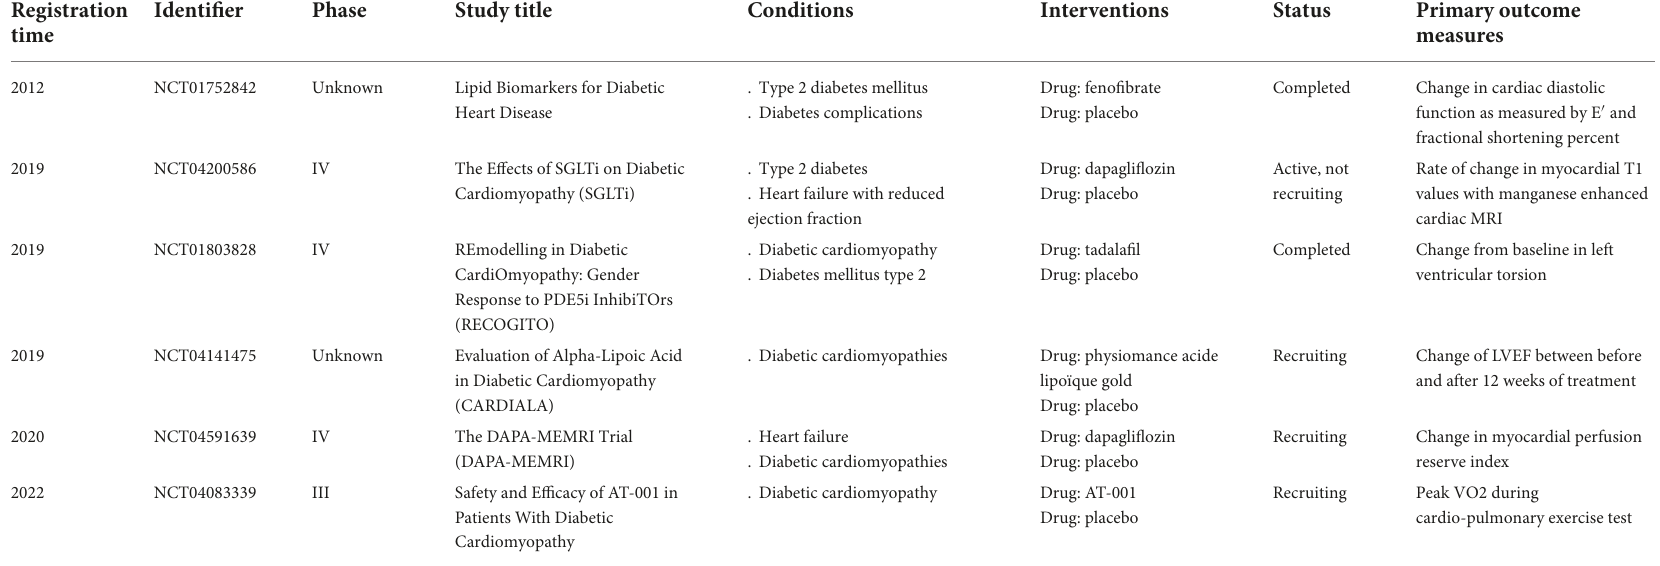
TABLE 1 Clinical registered studies for diabetic cardiomyopathy targeting